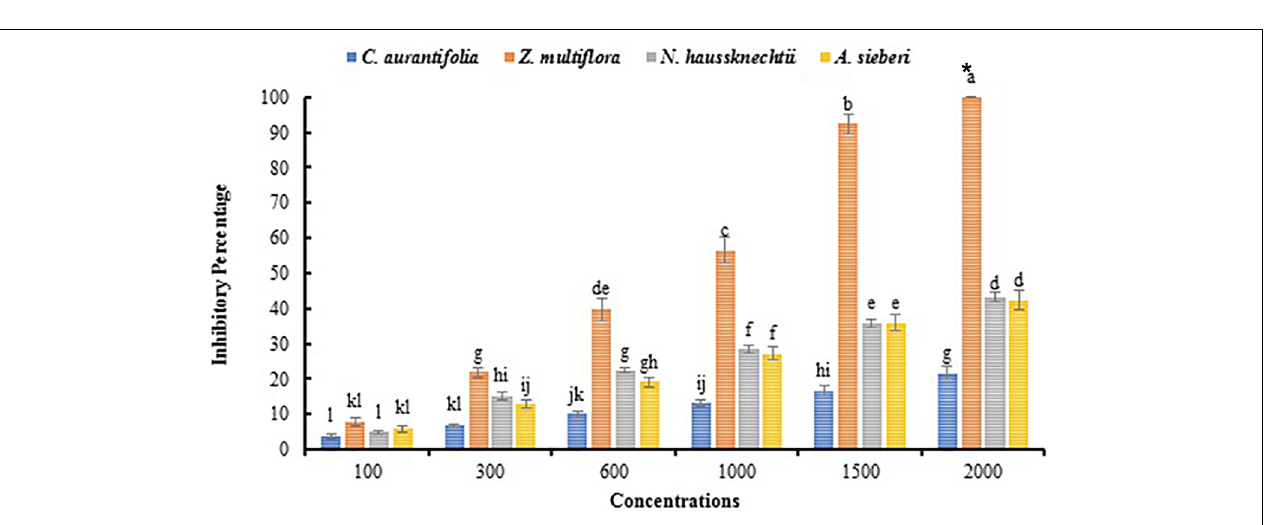
FIGURE 3 | Comparison of mean inhibitory percentage of A. solani mycelial growth with EOs in vitro . The symbol “ ∗ ” indicates the fungistatic